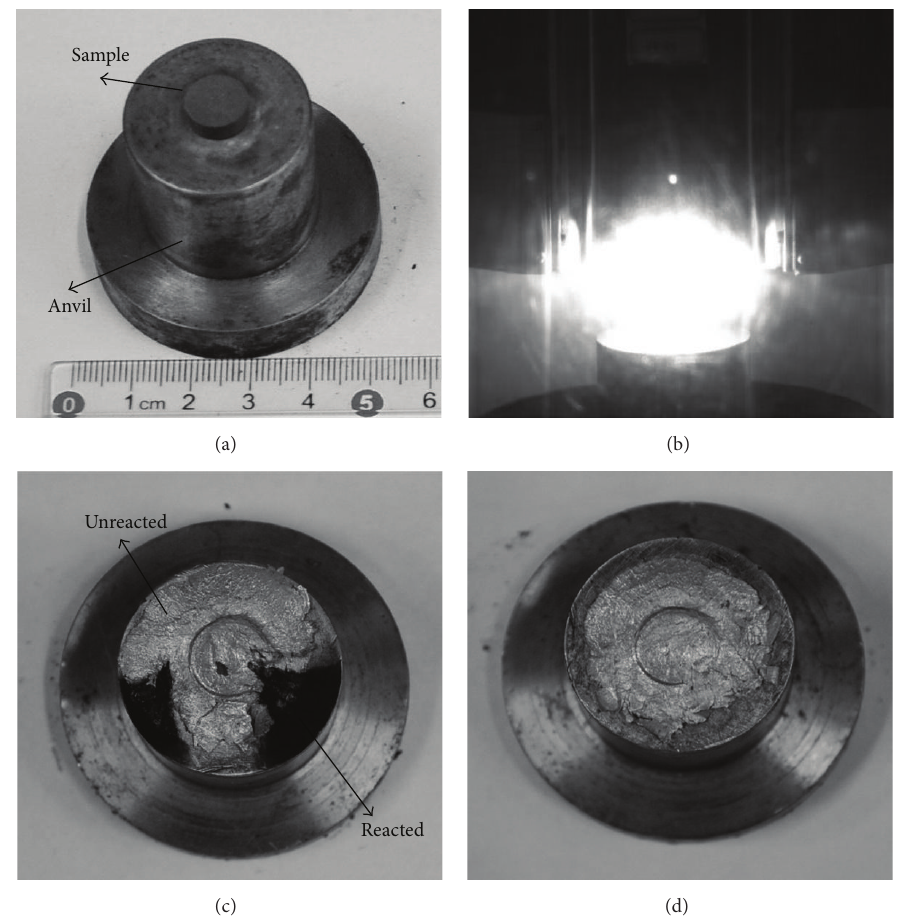
Figure 1: Impact-initiated reaction of Al-PTFE in drop-weight test. (a) Al-PTFE sample placed on the anvil before the drop-weight test. (b) Flame captured by high-speed photography in the test; (c) reacted Al-PTFE in the test; (d) unreacted Al-PTFE in the